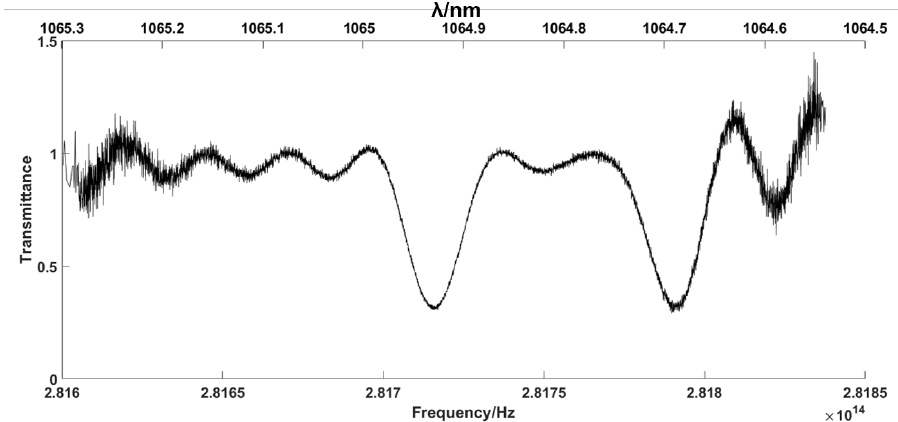
Figure 9. Simulation inversion from the RF domain to the OF domain.